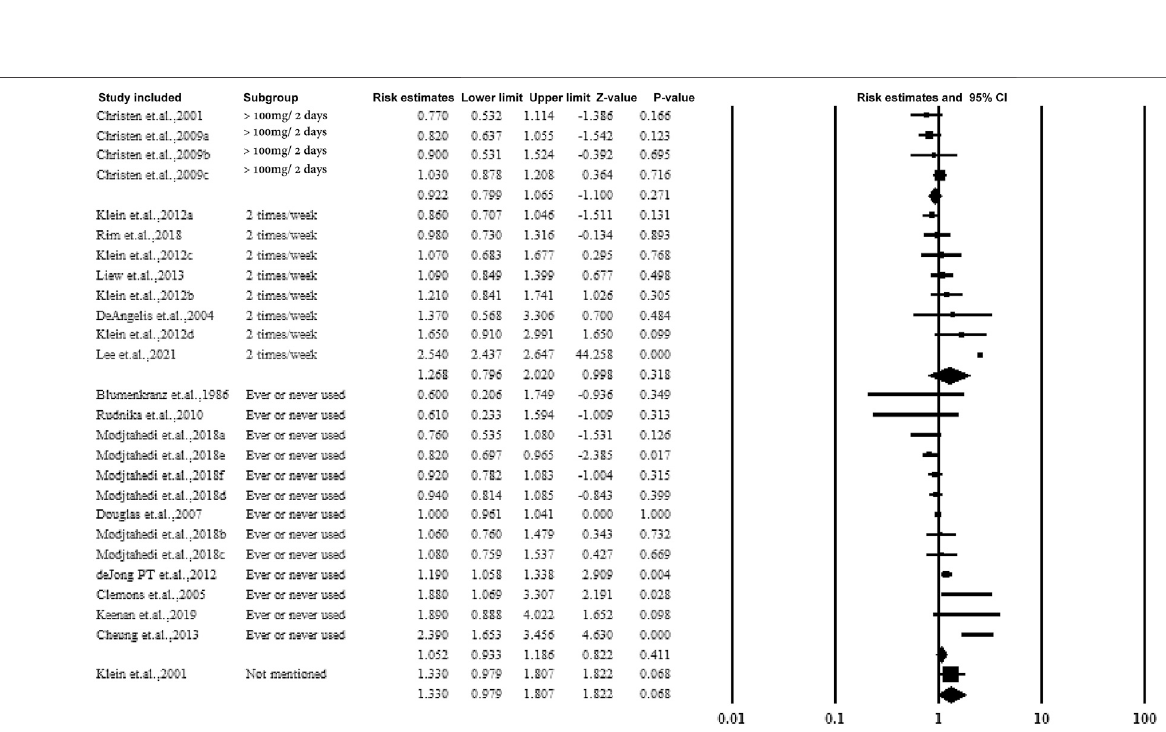
Frontiers in Pharmacology |